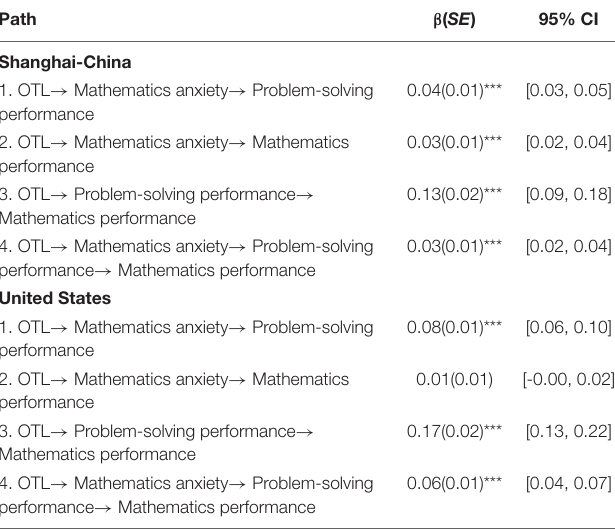
TABLE 5 | Indirect effects of OTL on student mathematics